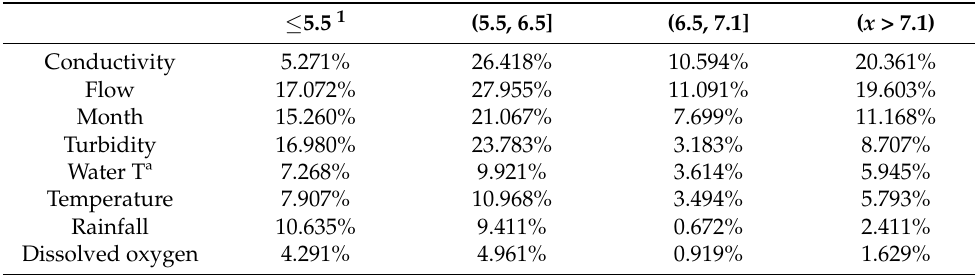
Table 2. Local impact analysis with pH target states. Results of the Relative Binary Mutual Informa- tion (RBMI)